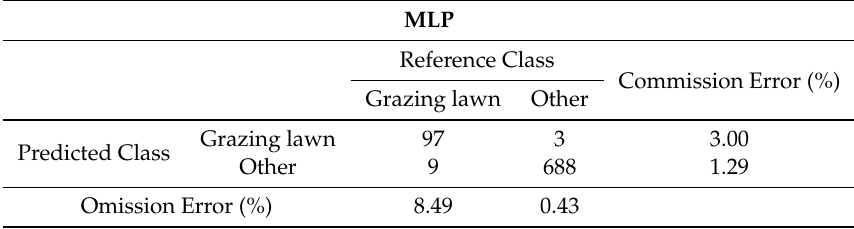
Table A5. Confusion matrix summarising results from Multilayer Perceptron (MLP) model classification of grazing lawn and other cover.